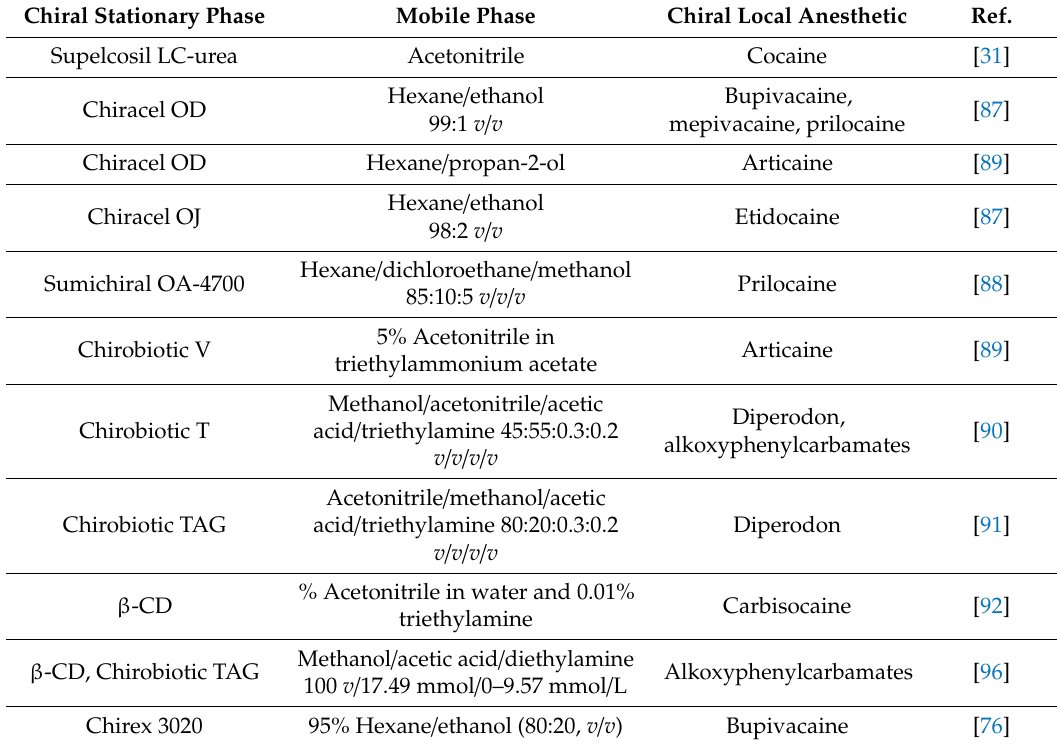
Table 2. Chiral stationary phases and mobile phases used to separate local anesthetics by HPLC. Chiral Stationary